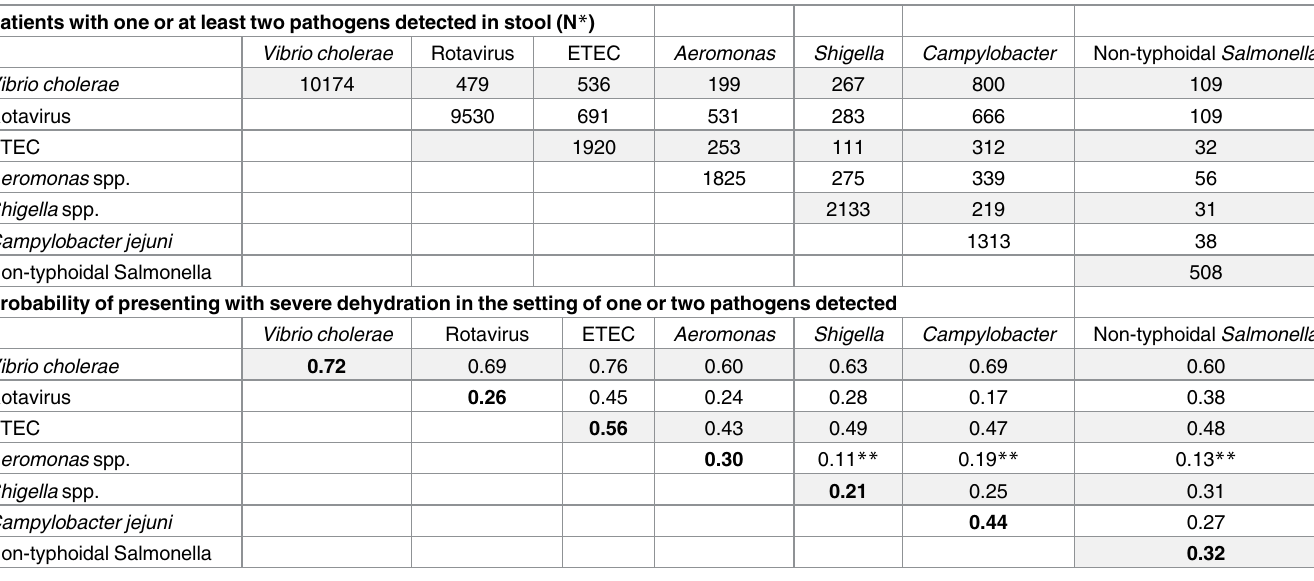
Table 3. Age- and sex-adjusted probability of presenting with severedehydration as a function of single or dual-pathogen combinations. Patients with one or at least two pathogens detected in stool (N * )